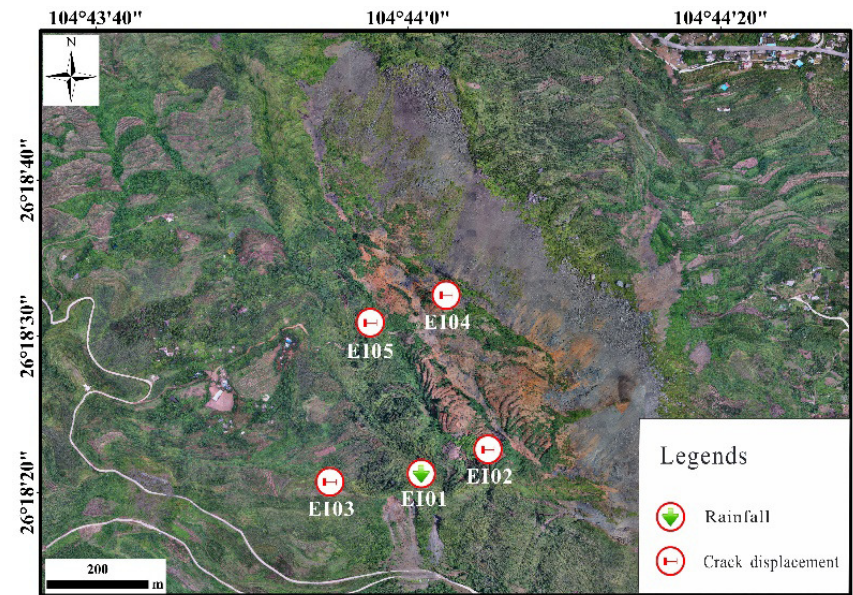
Figure 3. Schematic diagram of monitoring equipment